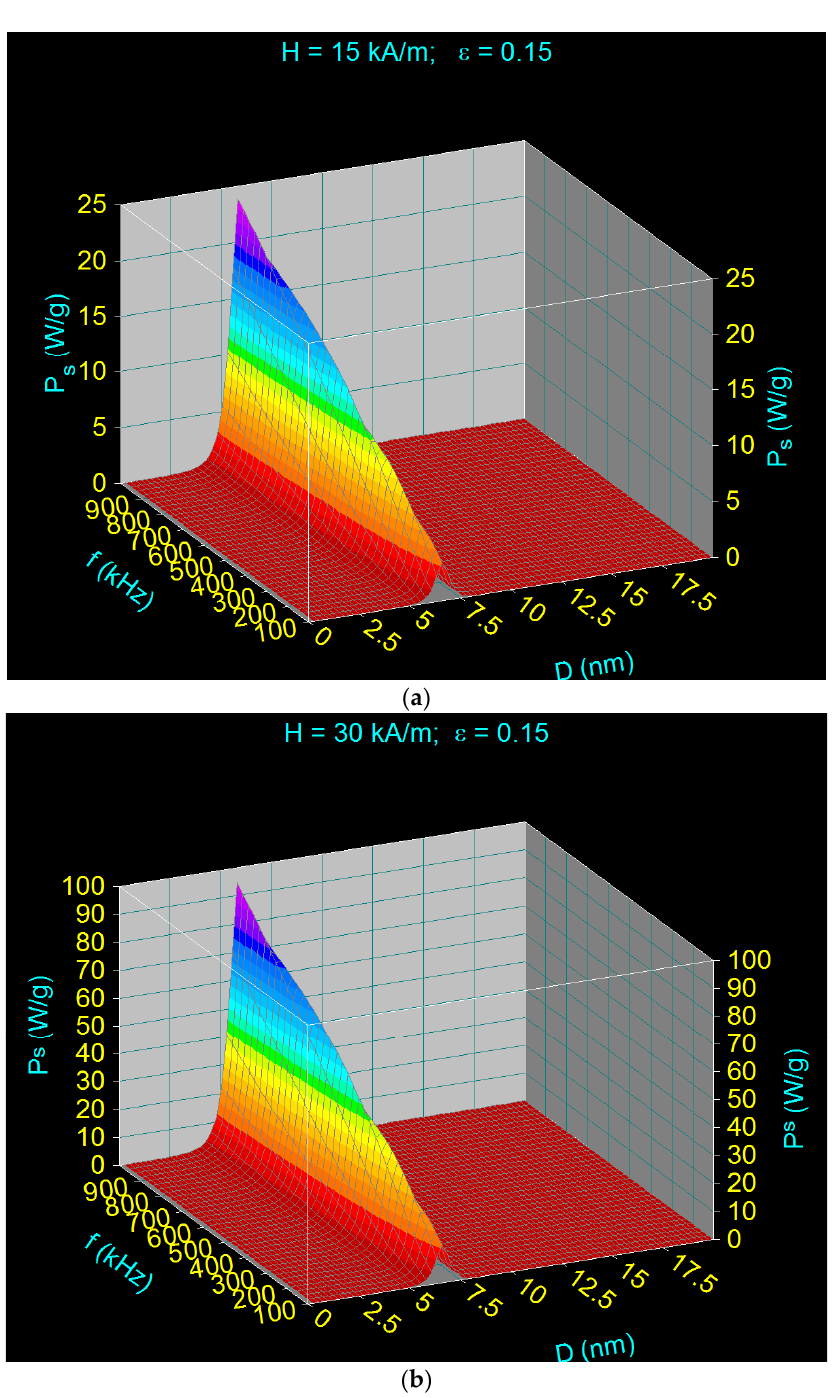
Figure 1. The specific loss power (P s ) as a function of CoFe 2 O 4 nanoparticles diameter (D) and magnetic field frequency (f) for amplitude of the magnetic field of ( a ) 15 kA/m and ( b ) 30 kA/m.